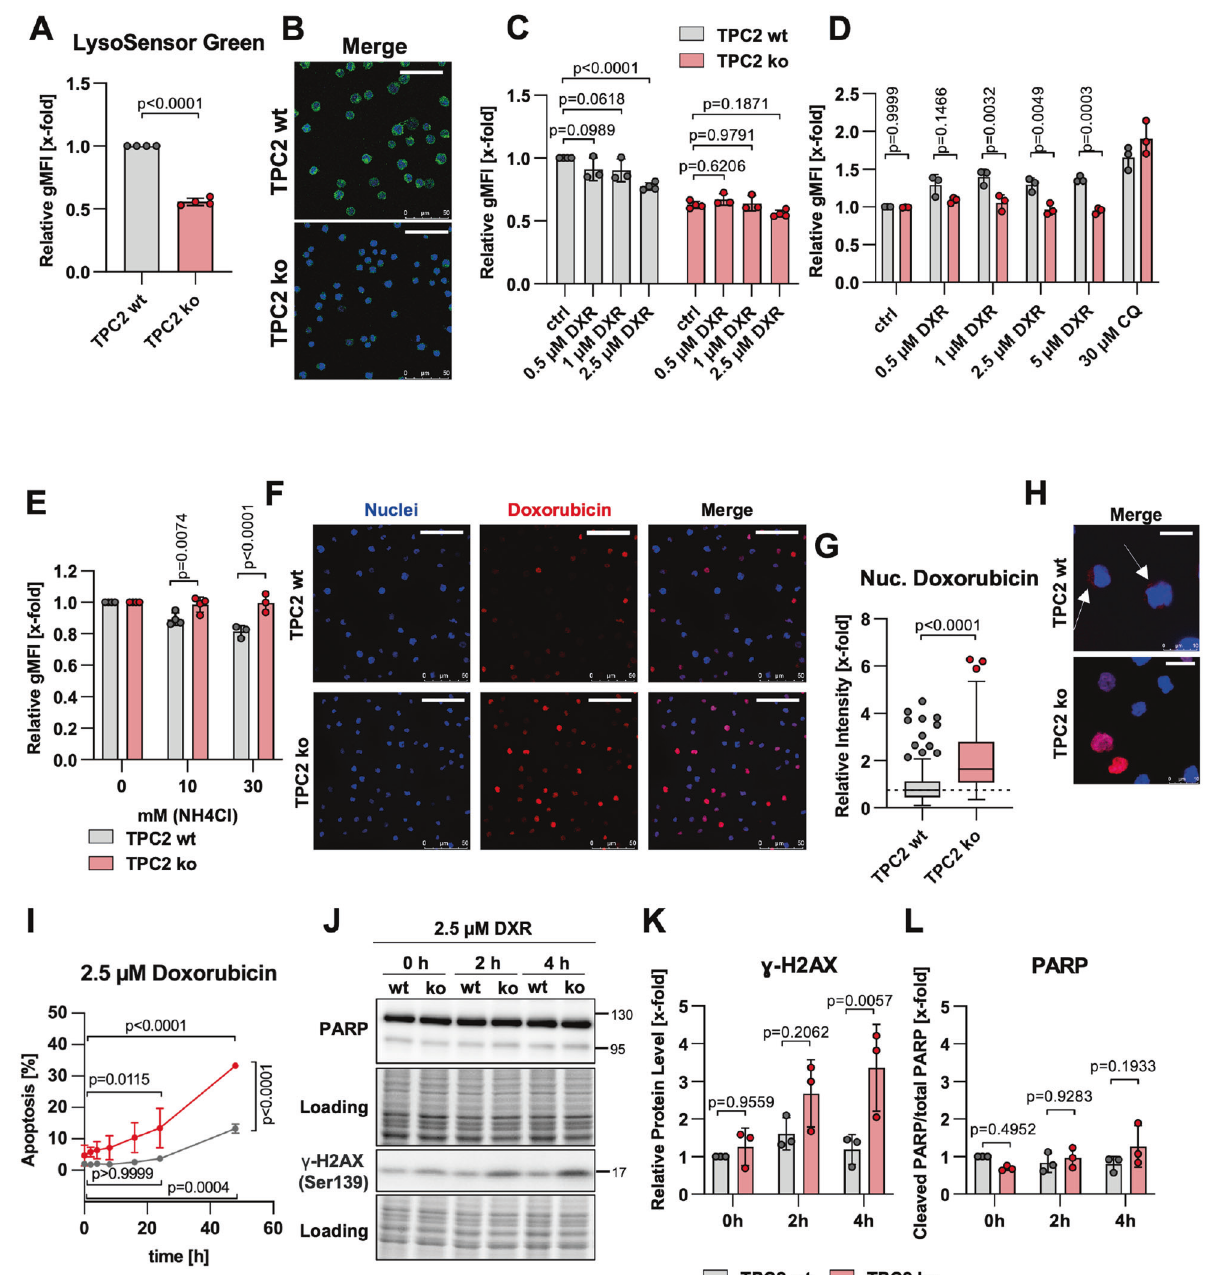
Fig. 4 Loss of TPC2 function alters intracellular drug distribution. A Lysosomal acidity was assessed by LysoSensor Green staining and fl ow cytometry. Cells with more acidic lysosomes show increased LysoSensor fl uorescence. B VCR-R CEM TPC2 wt and TPC2 ko cells were loaded with LysoSensor Green and fl uorescence intensity was analyzed by confocal microscopy (scale bar is 50 µm). C Lysosomal pH was assessed by LysoSensor Green staining and fl ow cytometry after 30 min of treatment. D Lysosomal volume was assessed by LysoTracker Green staining and fl ow cytometry after 4 h of treatment. E VCR-R CEM TPC2 wt and TPC2 ko cells were treated with 5 µM doxorubicin in the presence or absence of different concentrations of the lysosomotropic compound ammonium chloride for 24 h. Intracellular doxorubicin fl uorescence was analyzed by fl ow cytometry. F VCR-R CEM TPC2 wt and TPC2 ko cells were treated for 4 h and nuclear doxorubicin (red) was determined by co- staining with Hoechst 33342 (blue) and confocal microscopy (scale bar is 50 µm) and quanti fi ed ( G ) using ImageJ. 119 TPC2 wt and TPC2 ko cells were analyzed in three independent experiments and data points are displayed as box and whiskers with Tukey depiction. H Zoom from ( F ). Arrows point to the cytoplasmic abundance of doxorubicin (scale bar is 10 µm). Note that brightness and contrast were adjusted to improve visibility ( B , F , H ). I VCR-R CEM TPC2 wt and TPC2 ko cells were treated with 2.5 µM doxorubicin, and apoptosis was analyzed by propidium iodide staining and fl ow cytometry. J Immunoblots of VCR-R CEM wt and TPC2 ko cells. K , L Quantitative evaluation of protein levels from ( J ). Data were acquired from at least three independent experiments. Statistical signi fi cance was analyzed by student ’ s t -test with Welch ’ s correction ( A ), two-way ANOVA with Sidak ’ s posttest ( C , D , E , K , L ), Mann – Whitney test ( G ), or two-way ANOVA with Tukey ’ s posttest ( I ). Data are shown as mean ± SD, apart from ( G